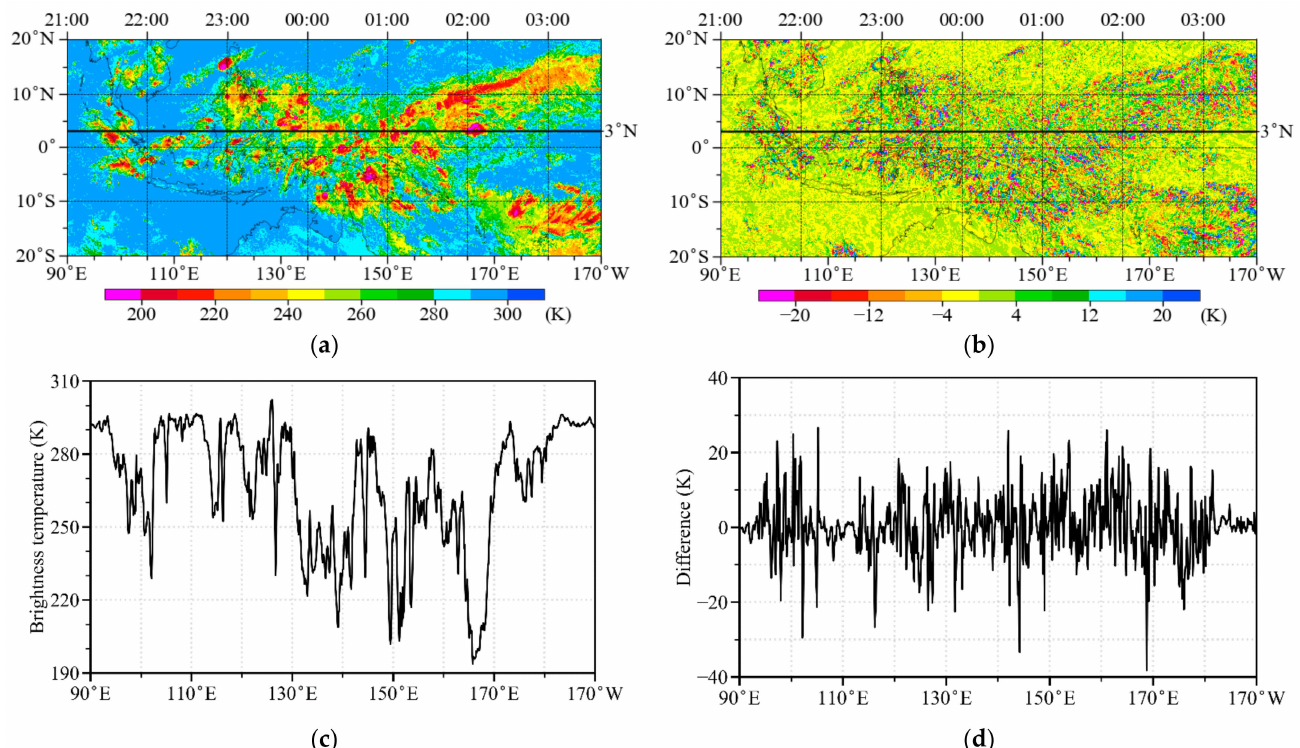
Figure 3. Horizontal distributions of ( a ) the sum of the PCA components 1–60 and ( b ) differences between the sum and the original brightness temperature observations at 1500 UTC 10 May 2021. The local time at the corresponding longitude is indicated at the top of the figure panel. ( c ) The sum and ( d ) the difference along 3 ◦ N (the black line in ( a , b